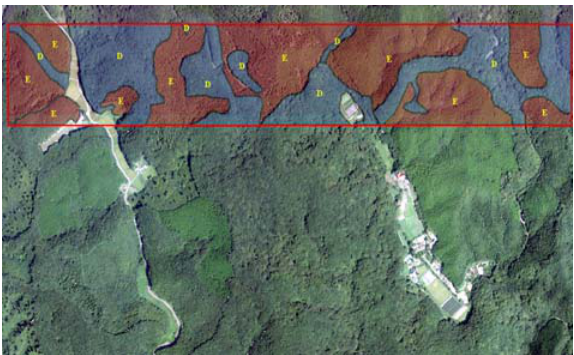
Figure 1. Orthophoto of the study area